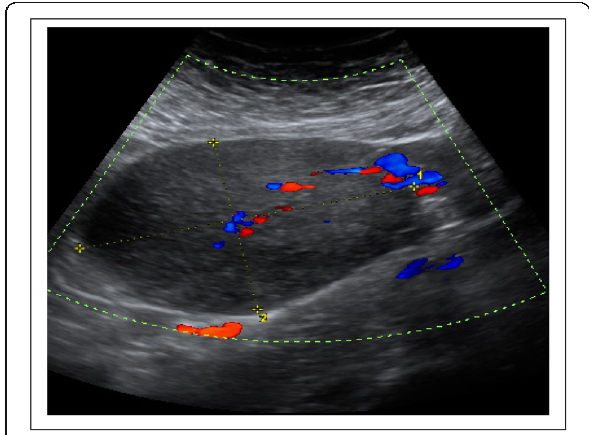
Fig. 9 A 60-year-old female patient showing an enlarged hypoechoic left ovary with central vascularity, hence was classified as GI-RADS 5. Panhystrectomy was done, and pathology revealed